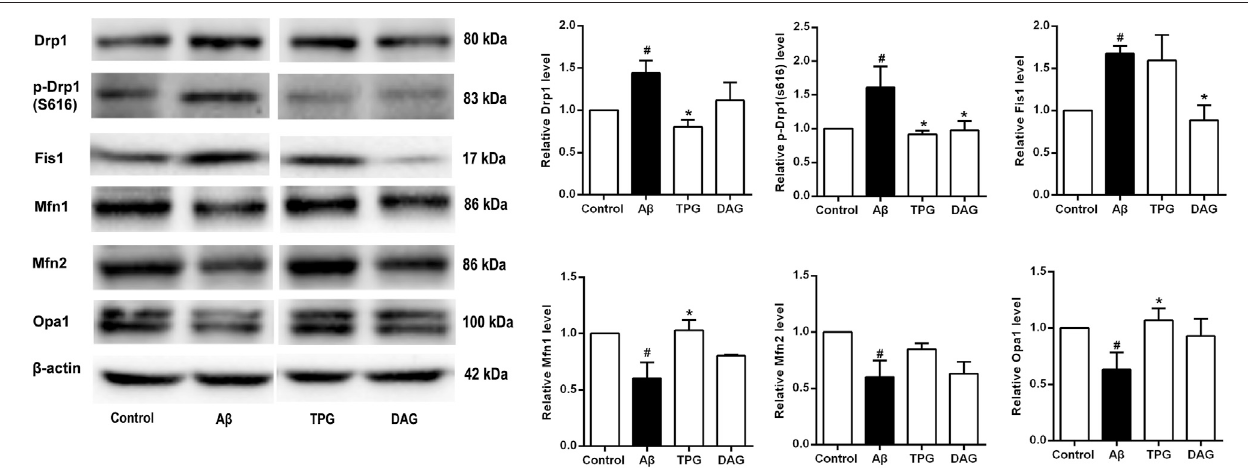
FIGURE7| TheregulationofTPGandDAGontheexpressionlevelofmitochondrialdynamics-relatedproteinsinA β 25 – 35 -exposedcells.Theexpressionlevelofthe proteins in each group was relative to the control group. All values were shown as mean ± SEM from three independent studies. Statistical analyses were performed using one-way ANOVA and Tukey-HSD post hoc comparisons. # p < 0.05, vs. control group; * p ＜ 0.05, vs. A β 25 – 35 models. TPG, tortoise plastron gelatin; DAG, deer antler gelatin.